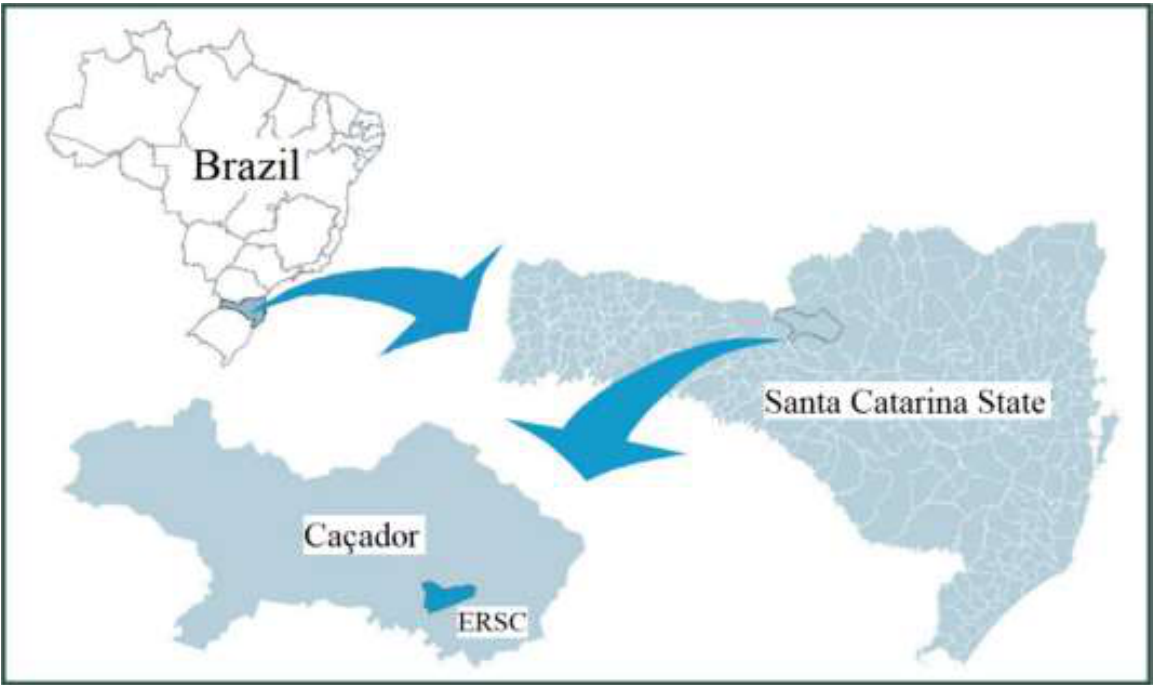
Figure 1. Location of the Embrapa Research Station in Caçador (ERSC), Santa Catarina State, Brazil.